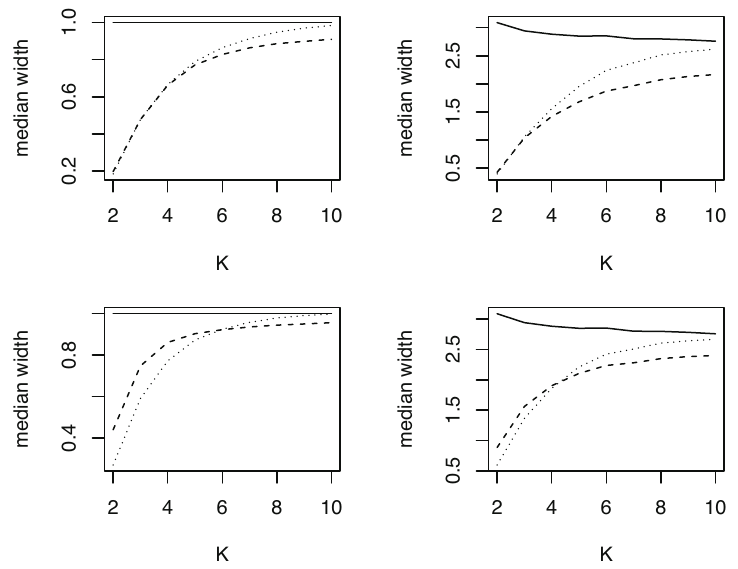
Figure 3: Median width of the AF bounds ( solid lines ) , DVS bounds ( dashed lines ) and SH bounds ( dotted lines ) for the causal risk di ff erence ( left panel ) and the causal risk ratio ( right panel ) , without and with parameter reduction ( top row and bottom row, respectively ) , as functions of the number of confounder levels K